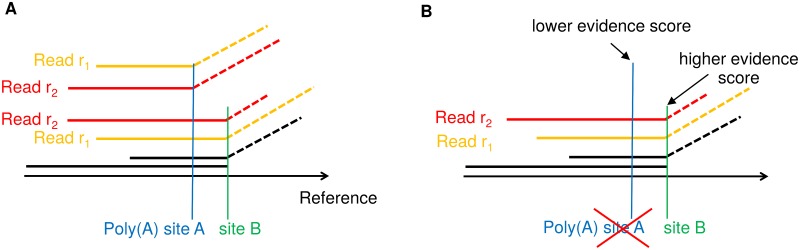
Resolution of poly(A) sites.(A) Example of two overlapping candidate poly(A) sites supported in part (but not only) by alternative alignments of the same reads r1 and r2. (B) After calculation of evidence scores, both read r1 and r2 are assigned to the poly(A) site with higher evidence (site B). Poly(A) site A is discarded as it is no longer supported by any reads. Site B is supported by ≥ rs reads with distinct alignments starts and, thus, is included in the final ContextMap 2 output.